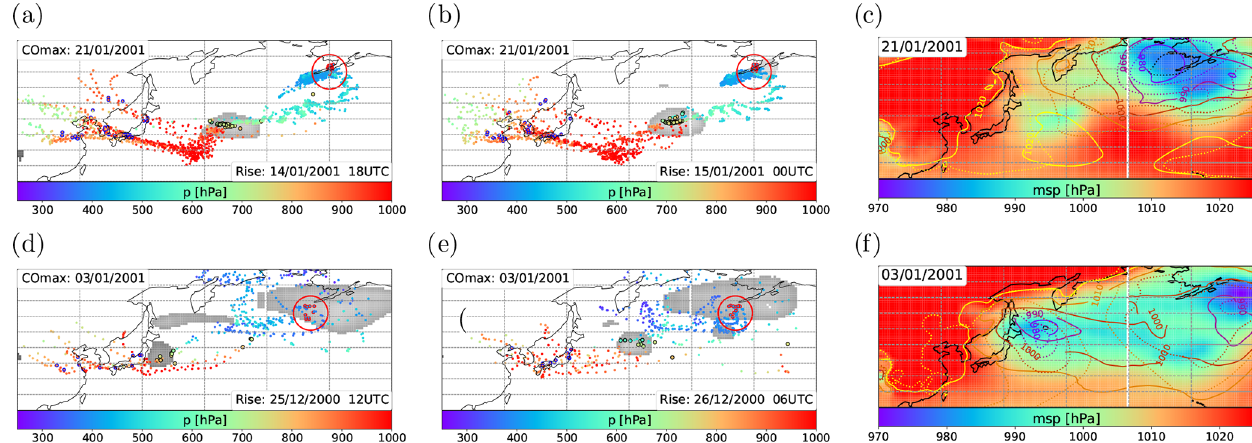
Figure 7. Panels (a) – (b) , (d) – (e) show trajectories that reach a common CO maxima cluster and have a common time at which they rise (above 800hPa). Black circles mark the trajectory position at the time of rise; blue circles mark the position of descent below 800hPa above a CO emission region. Grey-shaded areas mark the positions of low-pressure systems in the ERA-Interim data set. Panels (c) and (f) show daily averages of the mean sea-level pressure (msp; hPa) taken from ERA-Interim on 21 January 2001 (c) and 3 January 2001 (f) . Solid contour lines show the daily mean msp 1d prior to the case study day (i.e. on 20 January 2001 in c and on 2 January 2001 in f ), and dotted contour lines show it 2 d prior to the case study day (i.e. on 19 January 2001 in c and on 1 January 2001 in f ).